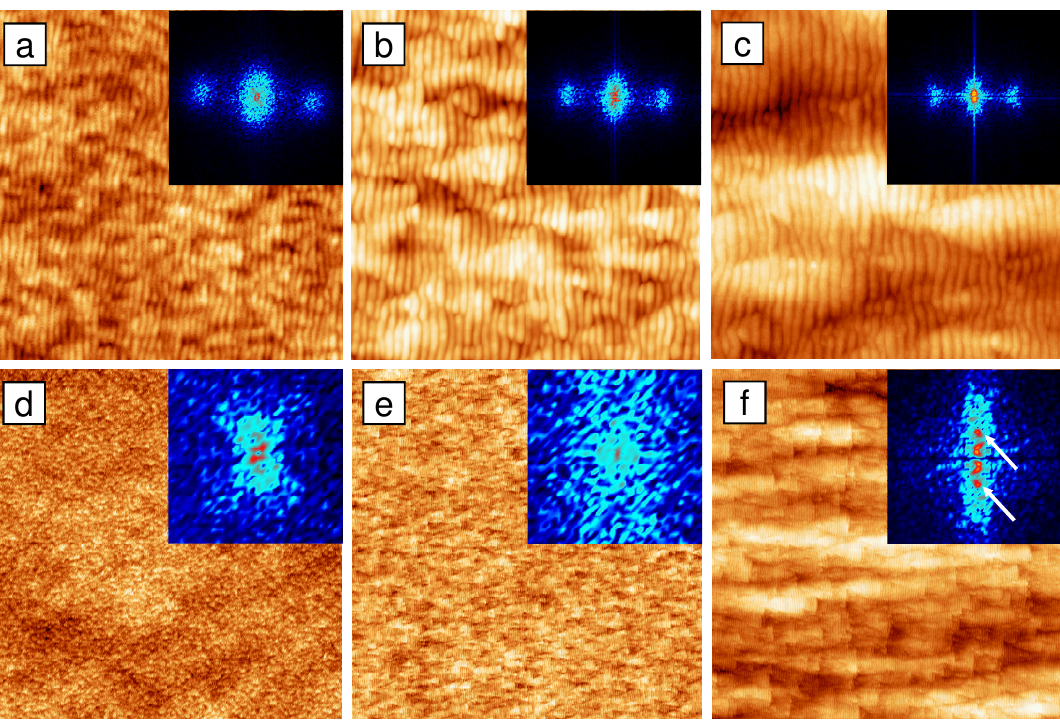
Figure 6. AFM images of Si(100) after sputtering with 300 eV Ar + ions at fluences Φ = 1 × 10 17 (a,d), 5 × 10 17 (b,e), and 1 × 10 19 cm − 2 (c,f). Height scales are 7 nm (a), 10 nm (b), 16 nm (c), 8 nm (d), 13 nm (e), and 28 nm (f). The size of the images is 1 × 1 µ m 2 (a–c) and 5 × 5 µ m 2 (d–f), respectively; the ion beam was entering from the left. Insets: corresponding FFT ranging from -75 to +75 µ m − 1 (a–c) and from -4 to +4 µ m − 1 (d–f)